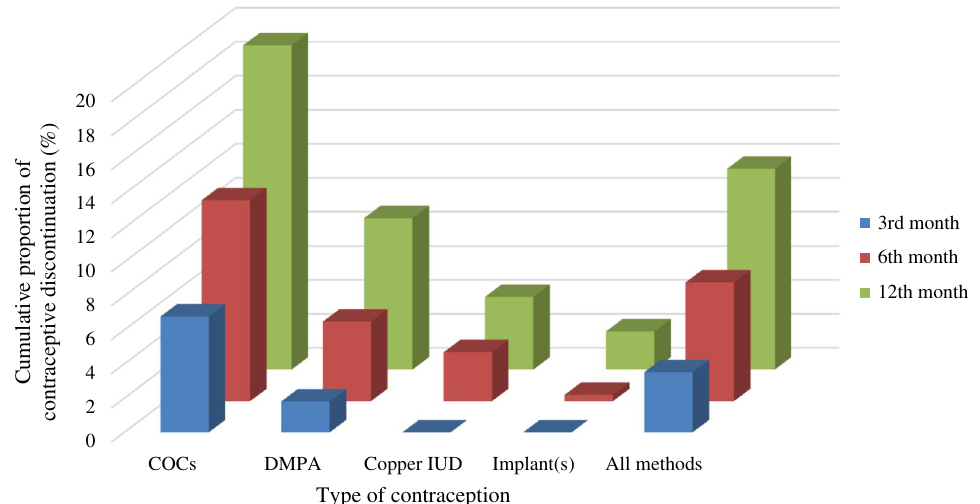
Figure 1. Cumulative proportion of contraceptive discontinuation at 3, 6 and 12 months.